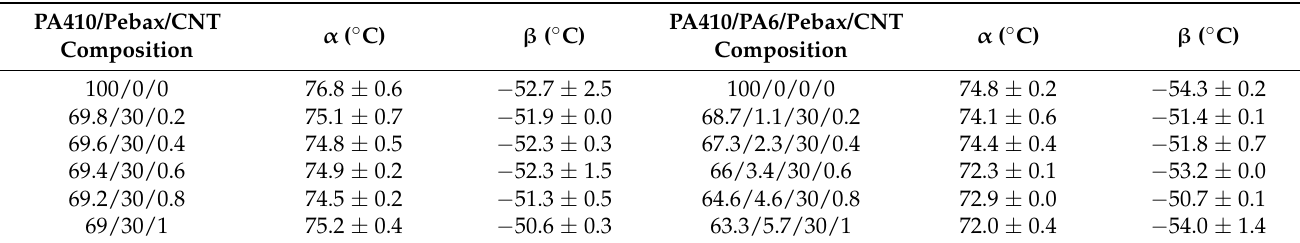
Table 2. The α and β transition values of PA410/Pebax/CNT and PA410/PA6/Pebax/CNT NCs obtained from DMTA